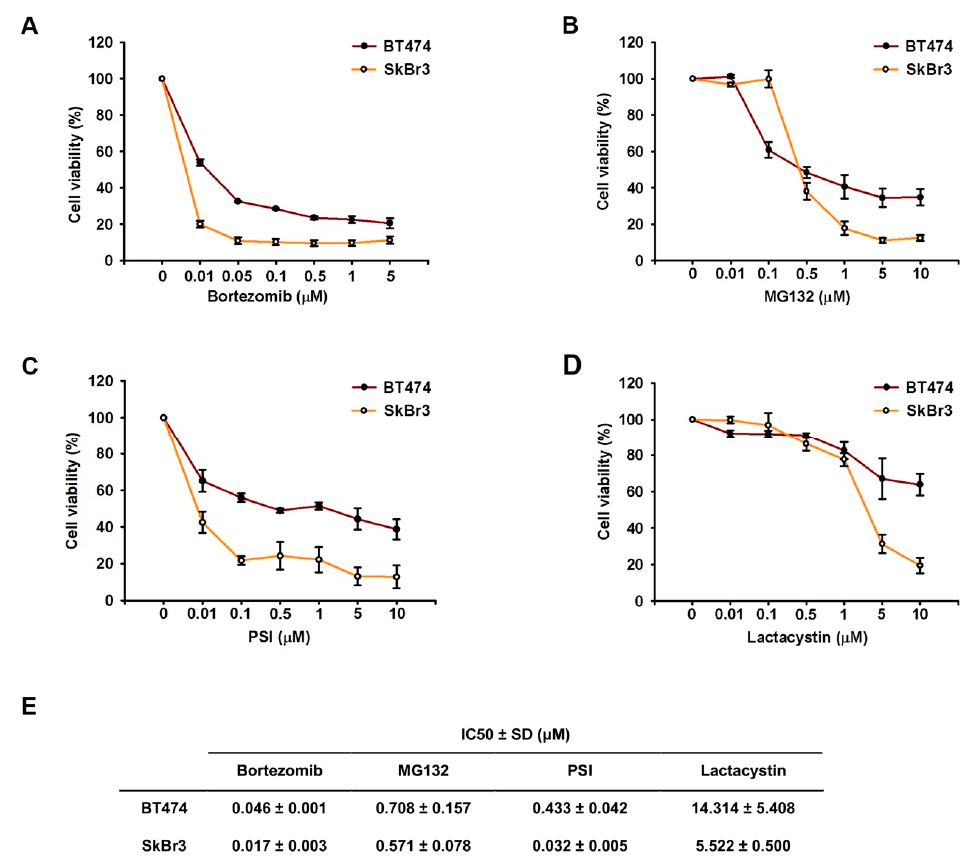
Figure 1. Proteasome inhibitors suppressed cell proliferation of HER2-positive breast cancer cell lines. BT474 and SkBr3 were treated by bortezomib ( A ), MB132 ( B ), PSI ( C ), and lactacystin ( D ) with